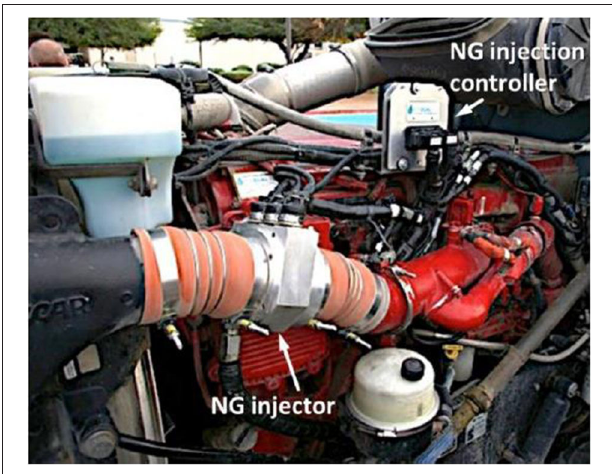
FIGURE 10 | NG injector location of the engine used in experiments.